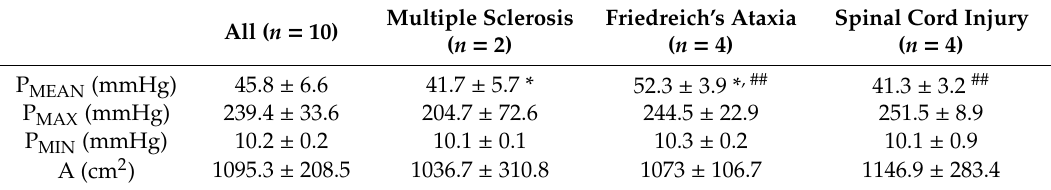
Table 2. Results of the blanket of pressures by groups and comparison between